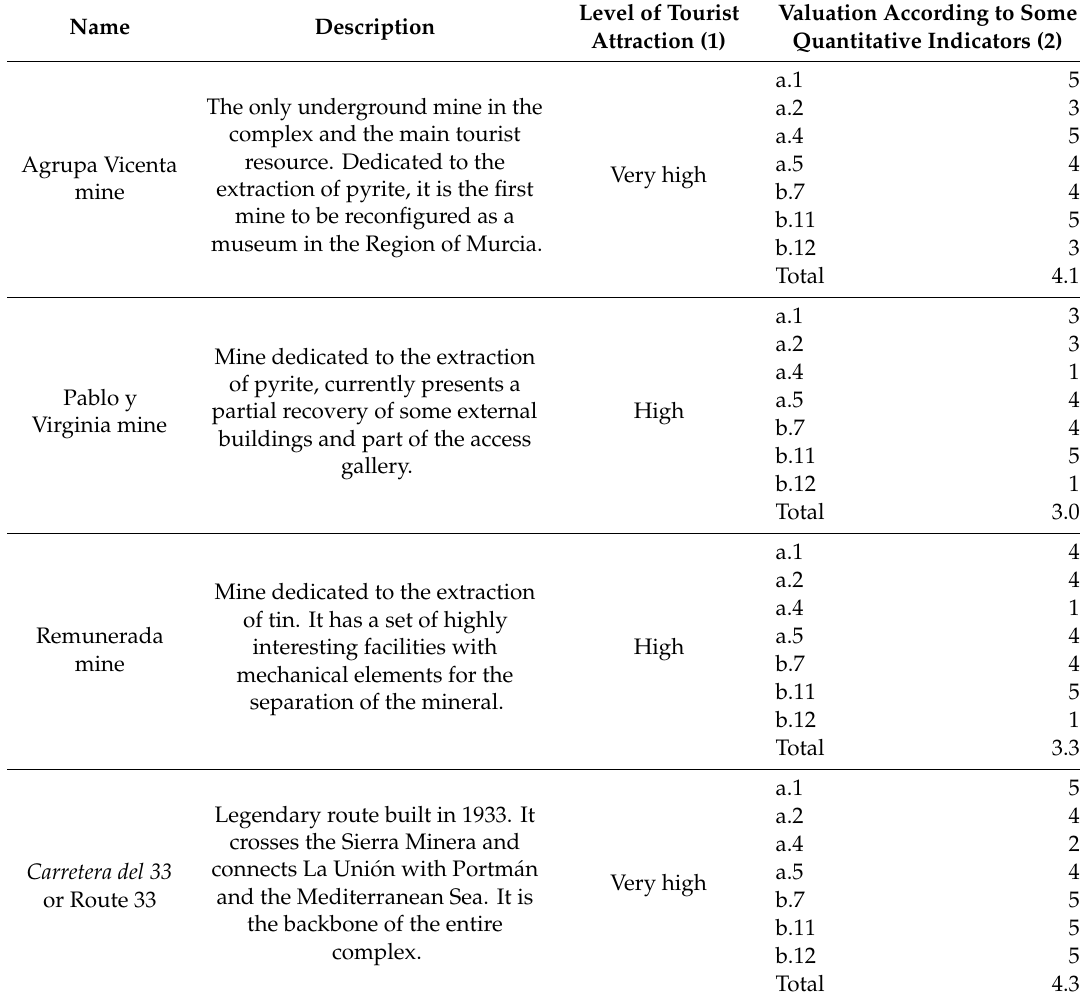
Table 5. List of the main tourist resources of the Mining